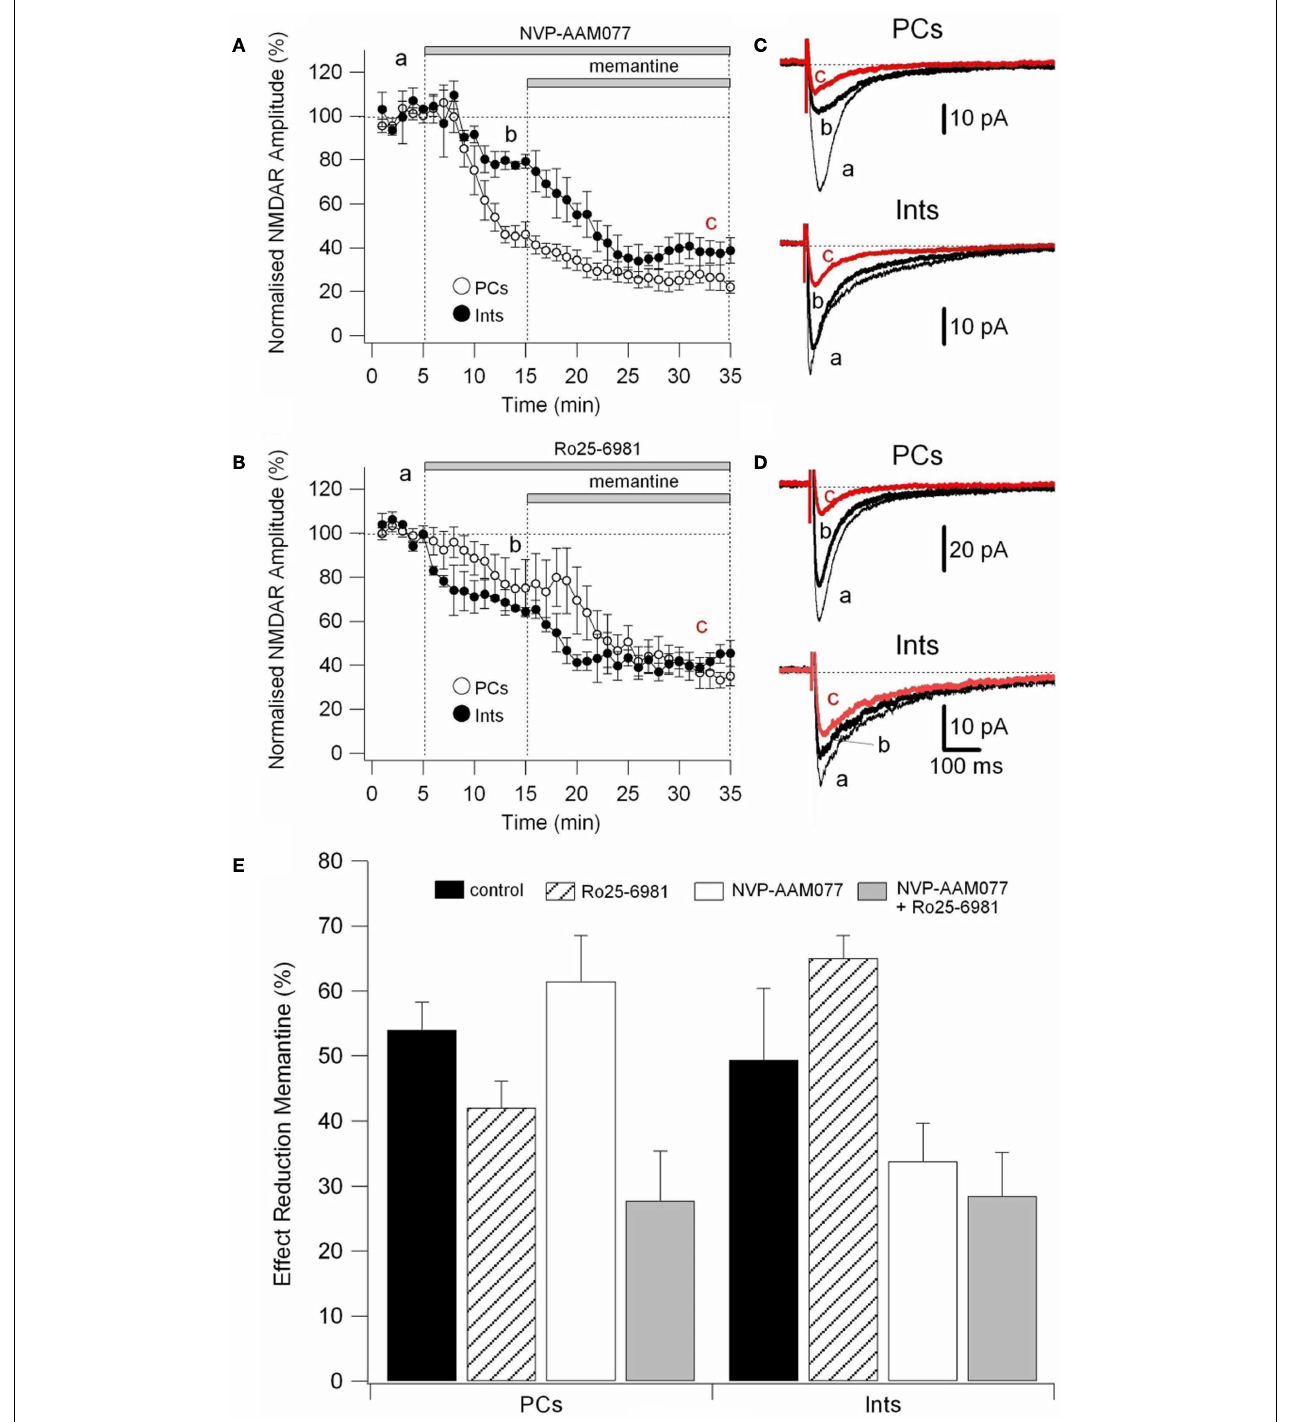
every 10s).The bars indicate the duration of drug application. (C,D) Examples of traces of NMDAR currents recorded in PCs (top) and Ints (bottom). Each trace is an average of 30 traces. (E) Histogram showing the effect of memantine (10 µ M) in PCs and Ints in control (black), in presence of Ro25-6981 (dashed lines), in presence of NVP-AMM077 (white), and in presence of NVP-AMM077 + Ro25-6981 (gray).The magnitude of the memantine effect was measured after 25min of